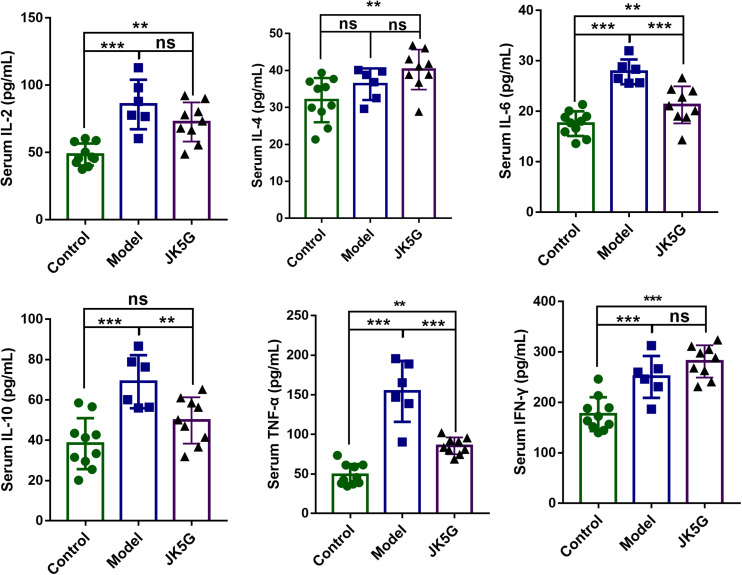
Microecological preparation reduces interleukin (IL)-6, IL-10, and tumor necrosis factor-alpha (TNF-α) levels in AOM/DSS-treated mice. Compared with the control group, the IL-6, IL-10, and TNF-α levels were significantly reduced compared to those in the model group. *p < 0.05; **p < 0.01; ***p < 0.001.